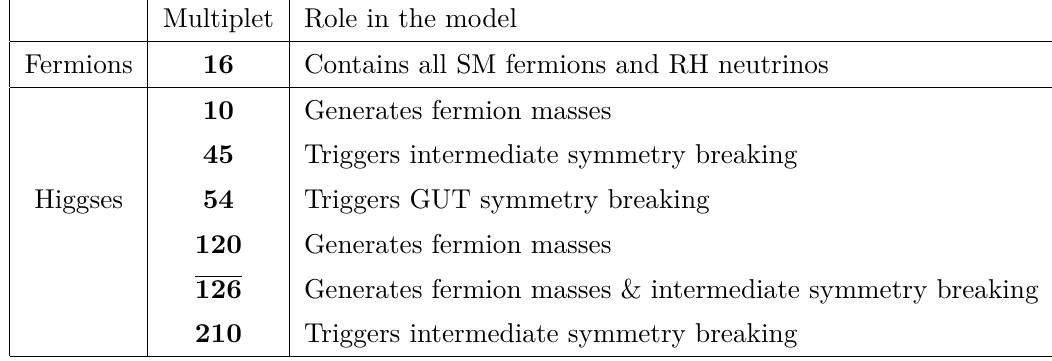
Table 1 . The SO(10) representations of the fermion and Higgs particles of our SO(10) GUT model and their roles.